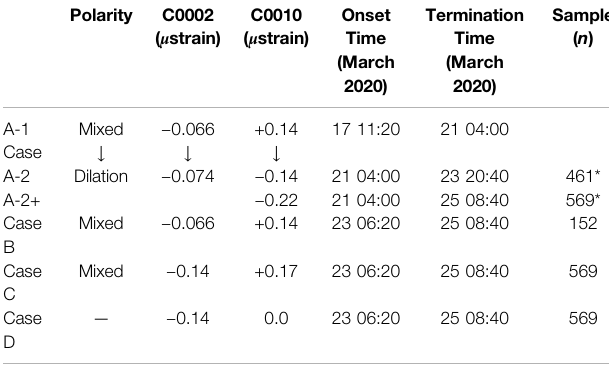
TABLE 4 | Possible cases of the volumetric strain change due tothe SSE in